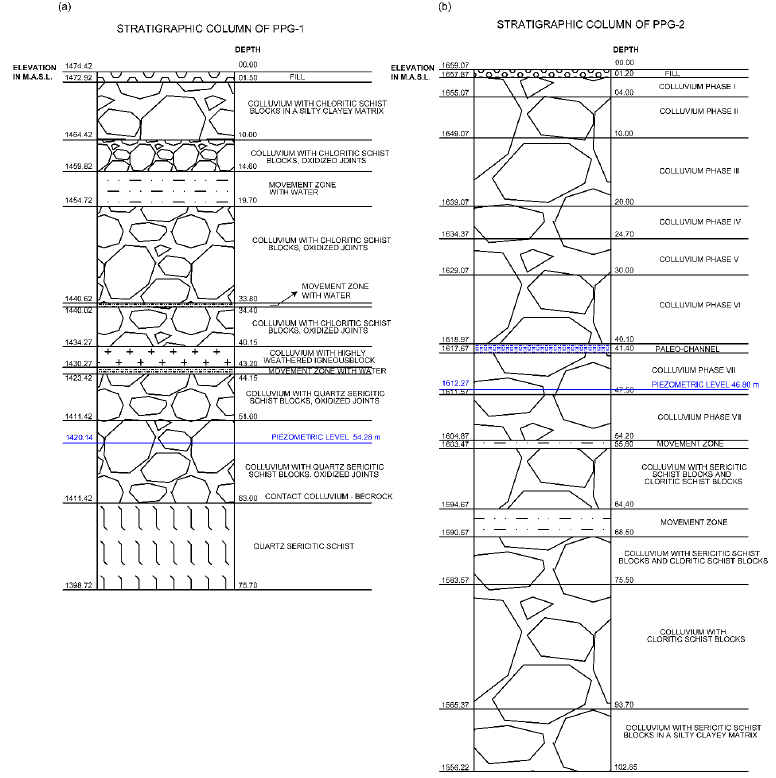
Figure A2. Stratigraphic columns for boreholes PPG-1 ( a ) and PPG-2 ( b ).